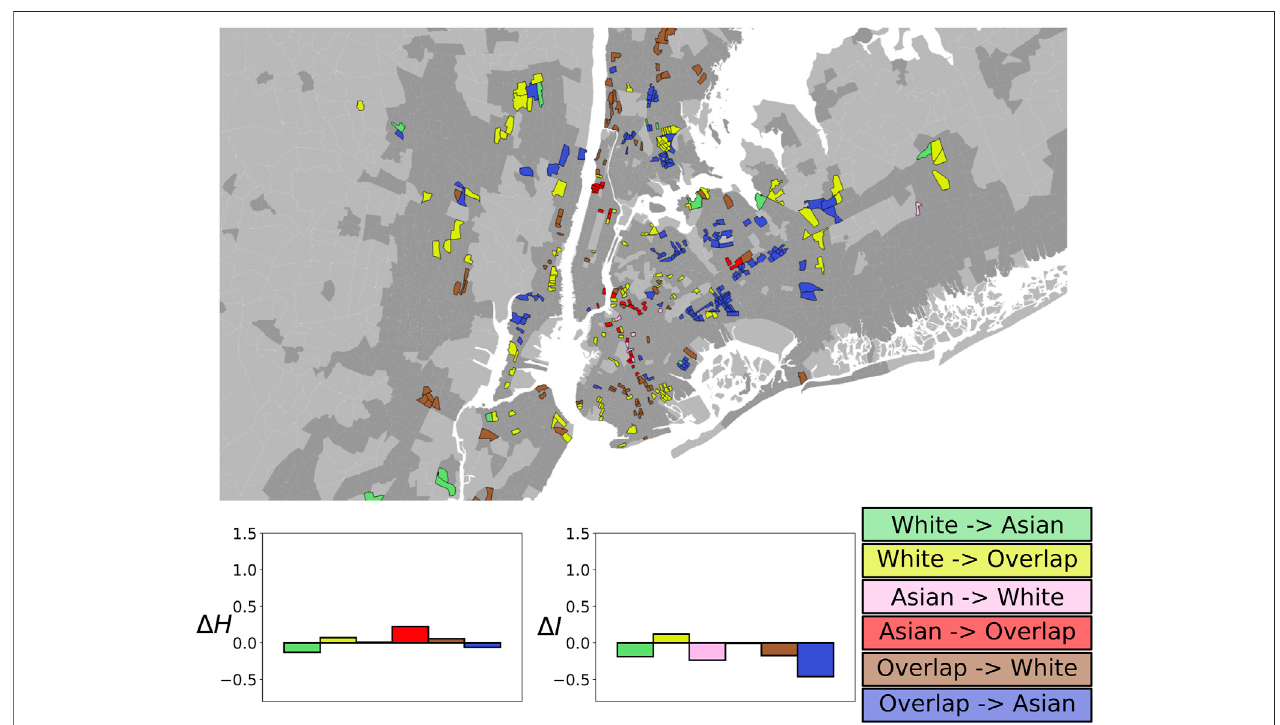
FIGURE6| TractsthatmigratedfromonezonetoanotherortotheOverlapzonefrom1990to2010:whiteandAsiancitizens.Tractsthatchangedzonefrom1990 to 2010 are shown on the map, while the colors indicate the change from white to Asian (green), from white to overlap (yellow), from Asian to white (pink), from Asian to overlap(red),fromoverlaptowhite(brown),andfromoverlaptoAsian(blue).Furthermore,foreachmigrationalternative,thevaluesof Δ H and Δ I areshownatthebottom panels.